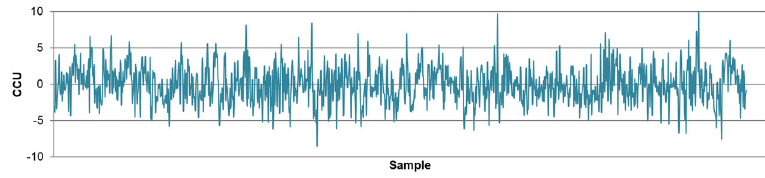
Figure A27. Prediction error of NN1 model training dataset.